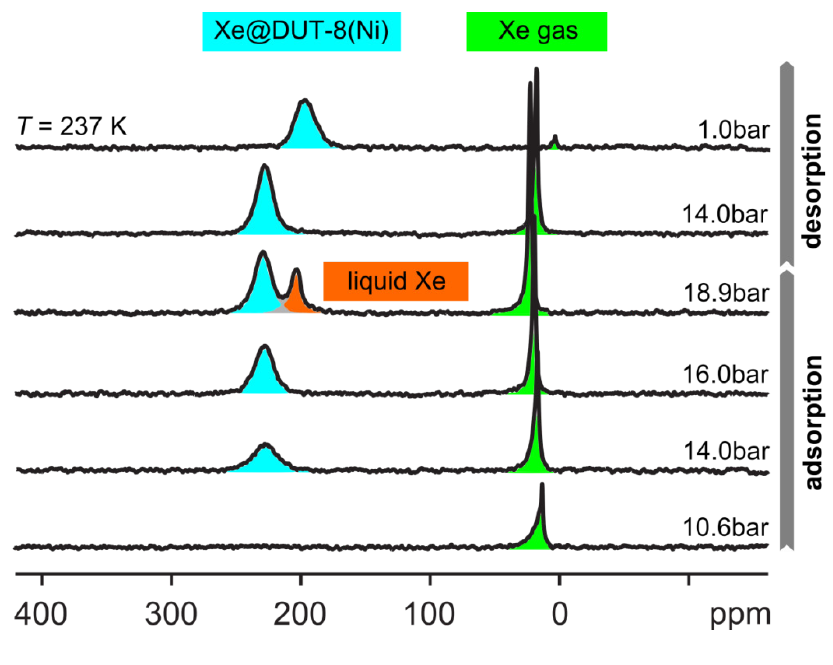
Figure 13. 129 Xe NMR spectra of DUT-8(Ni) pressurized with various amounts of xenon, measured at 237 K. Note that the initially closed structure opens during the adsorption experiment at a gate-opening pressure of ca. 12 bar whereas it remains open during desorption down to 1 bar (hysteresis). Reprinted with permission from [183]. Copyright 2011 American Chemical